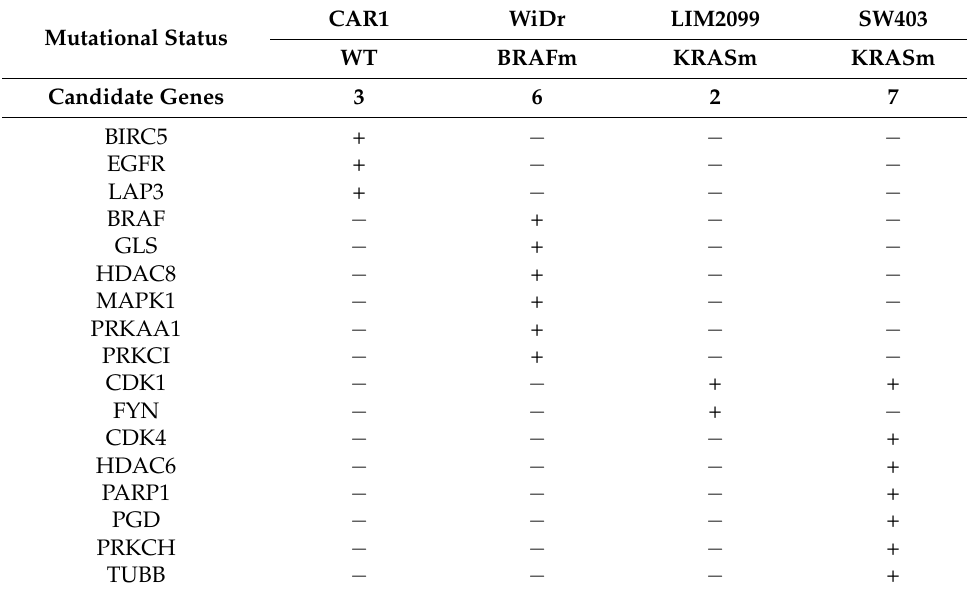
Table 1. Candidate hit genes identified by screening for synthetic lethality with pevonedistat. Four CRC cell lines with diverse mutational status were independently screened for library selective shRNA drop-out upon treatment with pevonedistat. Candidate genes (+) are reported for each cell line in alphabetical order. CAR1 WiDr Mutational Status